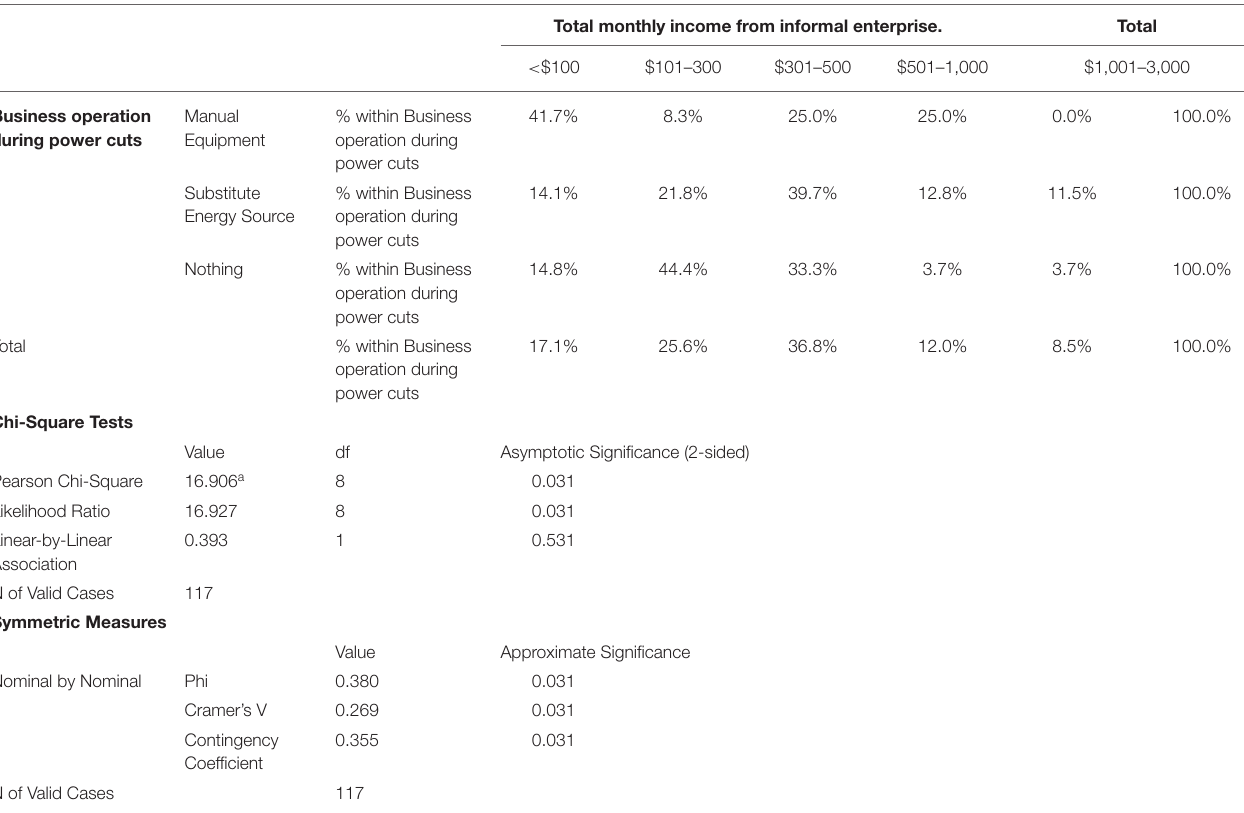
TABLE 4 | Association of income from informal business and mode of operation during power cuts. Total monthly income from informal enterprise.